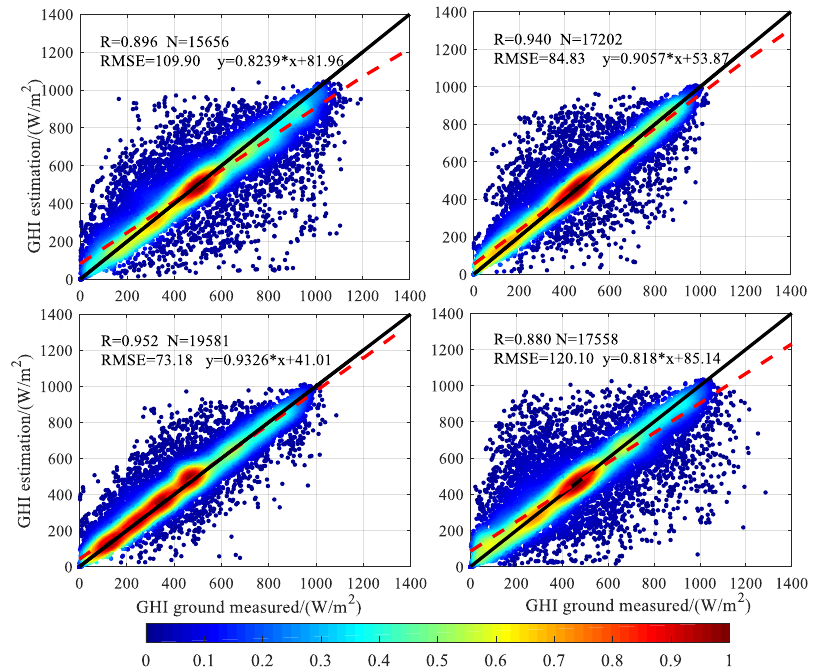
Figure 3. Scatter diagrams of the measurements (horizontal axis) and estimates (vertical axis) of the GHI for Zhangbei, Laoting, Hengshui, and Chengde (the upper left, upper right, lower left, and lower right, respectively). The color represents the frequency of each pair. R, Pearson correlation coefficient; RMSE, root mean square error.